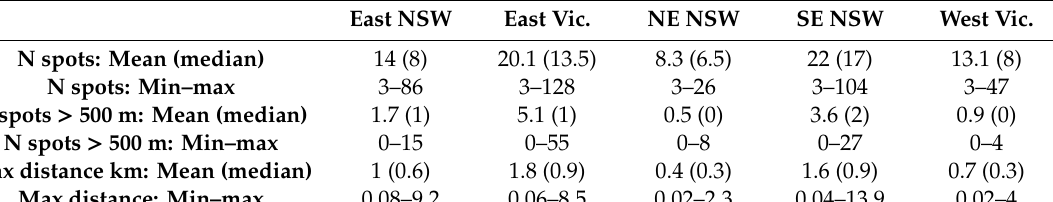
Table 2. Summary statistics for the three spotting measures by region.